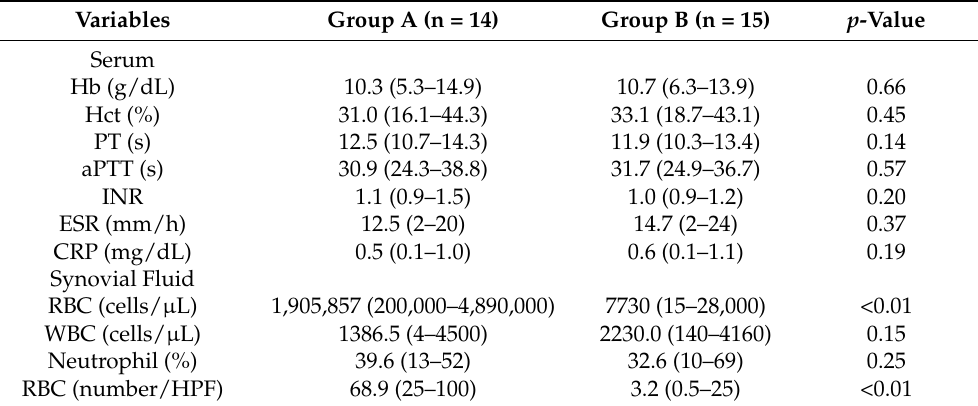
Table 2. Serologic test results and synovial fluid analyses between two groups.